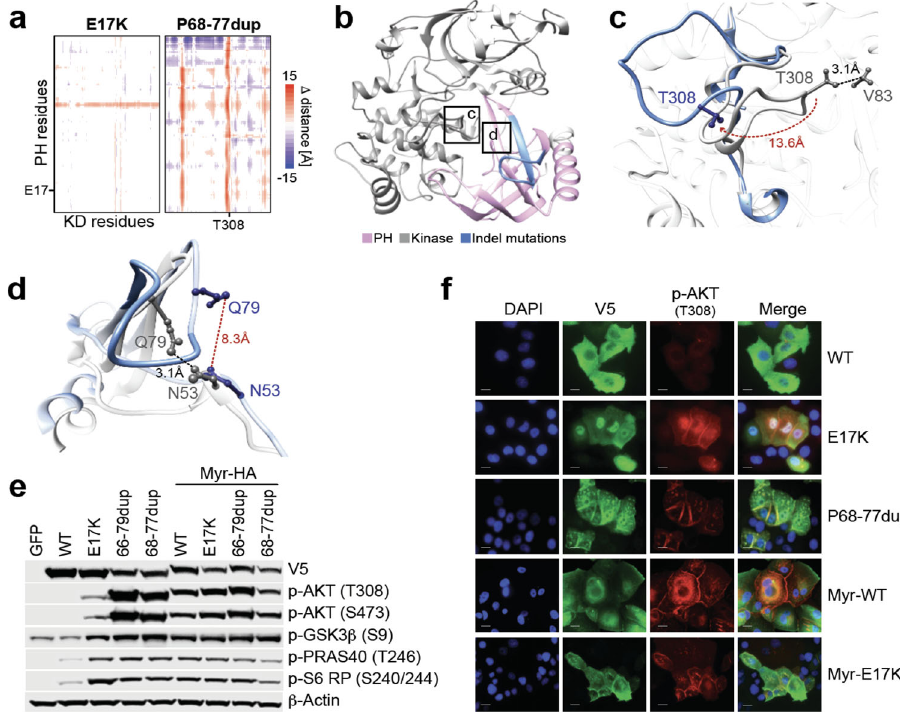
Fig. 3 Structural and signaling impact of AKT in-frame indels. a Molecular dynamic simulation of AKT1 indicated systematic displacement of the structure by the P68-C77dup mutation as compared to the E17K hotspot, as measured by changes in inter-residue distance between the PH and kinase domains. Duplication mutant-speci fi c displacement targeted the key regulatory phosphorylation site T308, among others. b The structure of AKT1 indicating the region affected by the cluster of paralogous in-frame indels in AKT1 and AKT2 (light blue) in the PH domain (purple). The kinase domain (KD) is shown in light gray and boxed are the two regions of greater detail shown in the indicated panels. c A detailed view of the 13.6 angstrom T308 displacement by the P68-C77dup mutation. d A detailed view of N53 in the inositol-binding region of the PH domain that is displaced by the duplication mutant breaking its WT hydrogen bonding with Q79. e MCF10a cells stably expressing either GFP, WT AKT1, or the indicated missense or duplication mutants and their myristoylated counterparts were incubated in assay medium overnight, and whole-cell lysates were prepared and immunoblotted with the indicated antibodies in order to assess pathway activation. Source data are provided as a Source Data fi le. f MCF10a cells stably expressing WT or mutant AKT1 and their myristoylated counterparts were incubated with assay media for four hours, after which the cells were fi xed, permeabilized, probed with antibodies for p-AKT (T308) and V5 tag (for AKT expression) and examined under fl uorescence microscope in order to determine the intracellular localization of the indicated AKT1 constructs. For panels ( e – f ), results are representative of at least three independent experiments performed. Scale bar: 40 μ